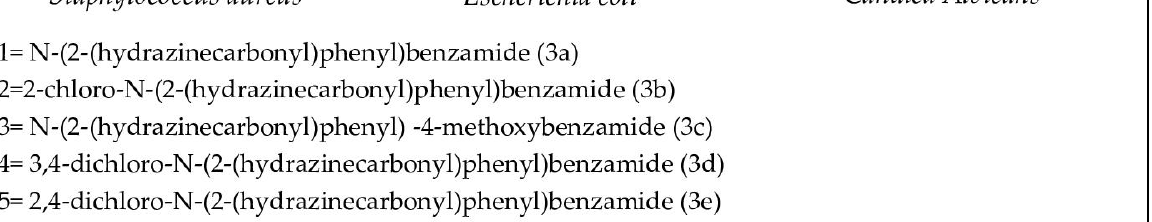
Figure 7. The result of antibacterial and antifungal activity by zone inhibition method.